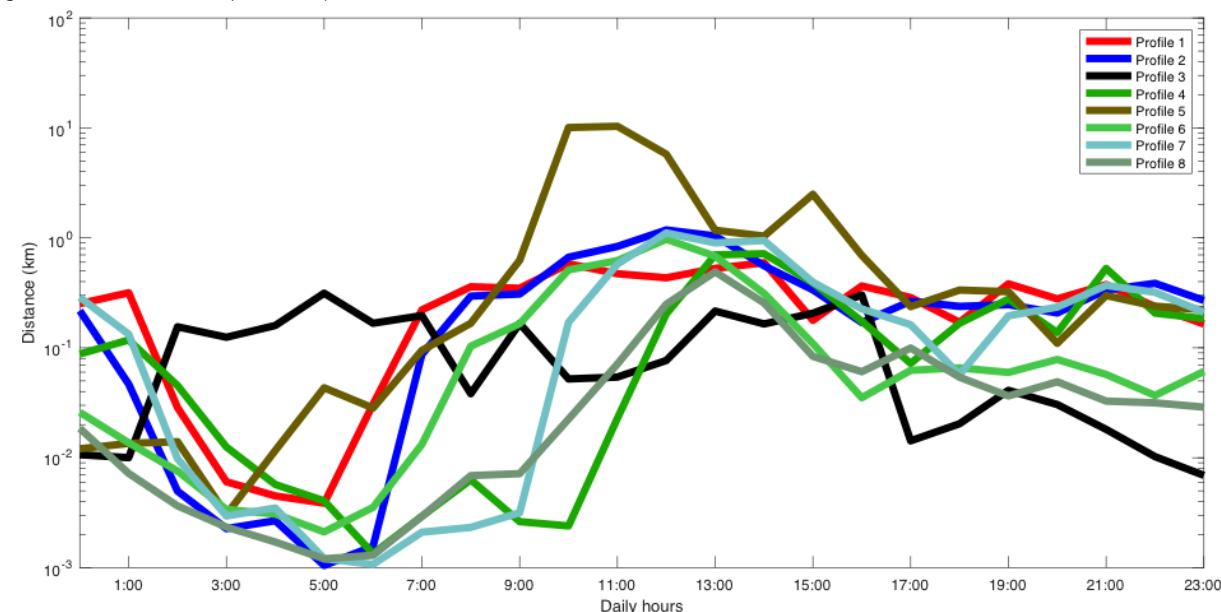
Figure 3. Distance traveled profiles of patient A.